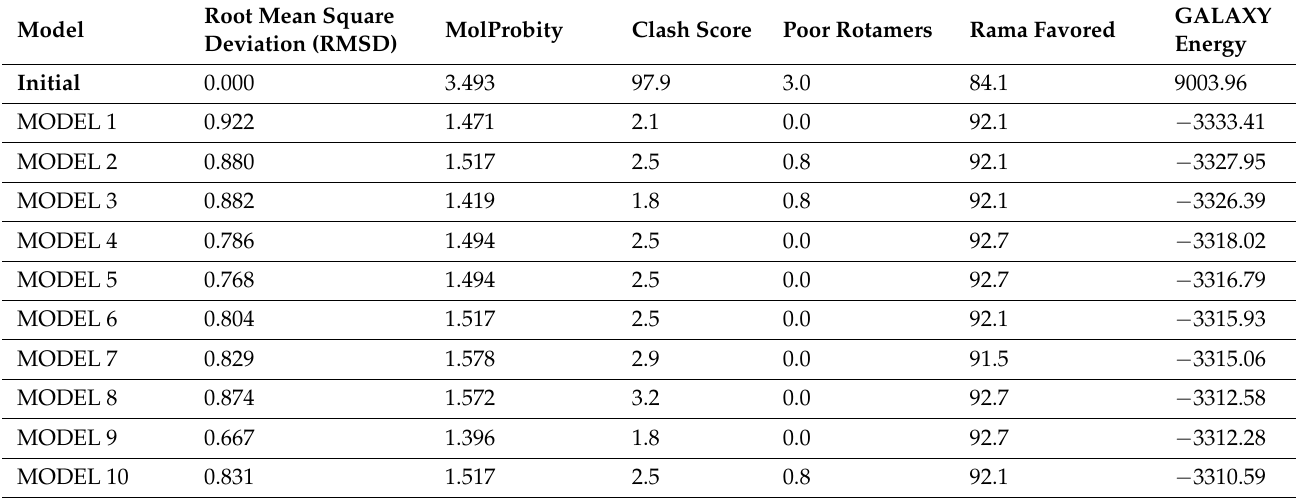
Table 2. Structural information for generated models of vaccine.